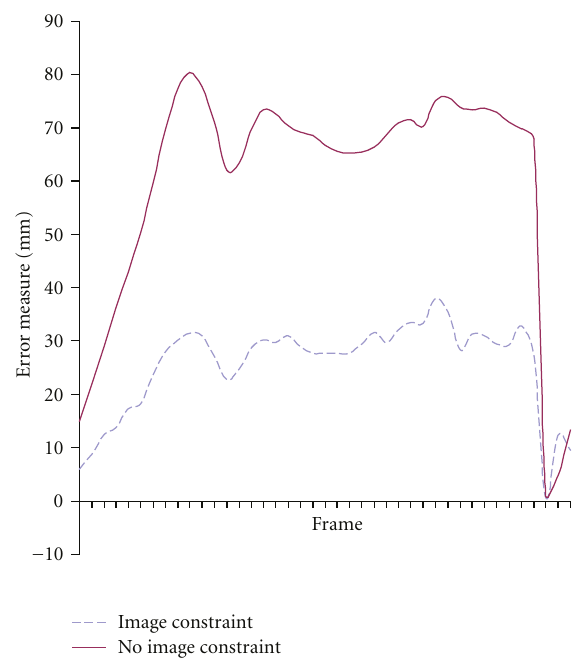
Figure 13: Knee’s estimation error by frame of the box sequence.